Question: What style of plot is this figure drawn as?
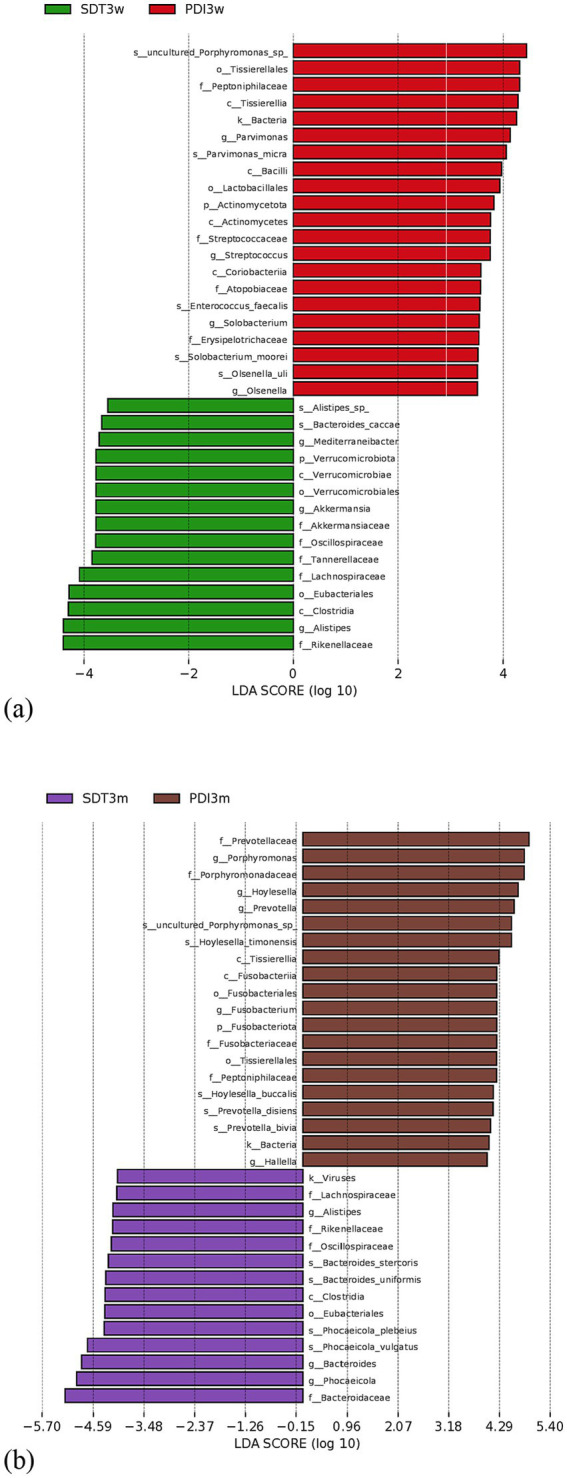
Answer: bar